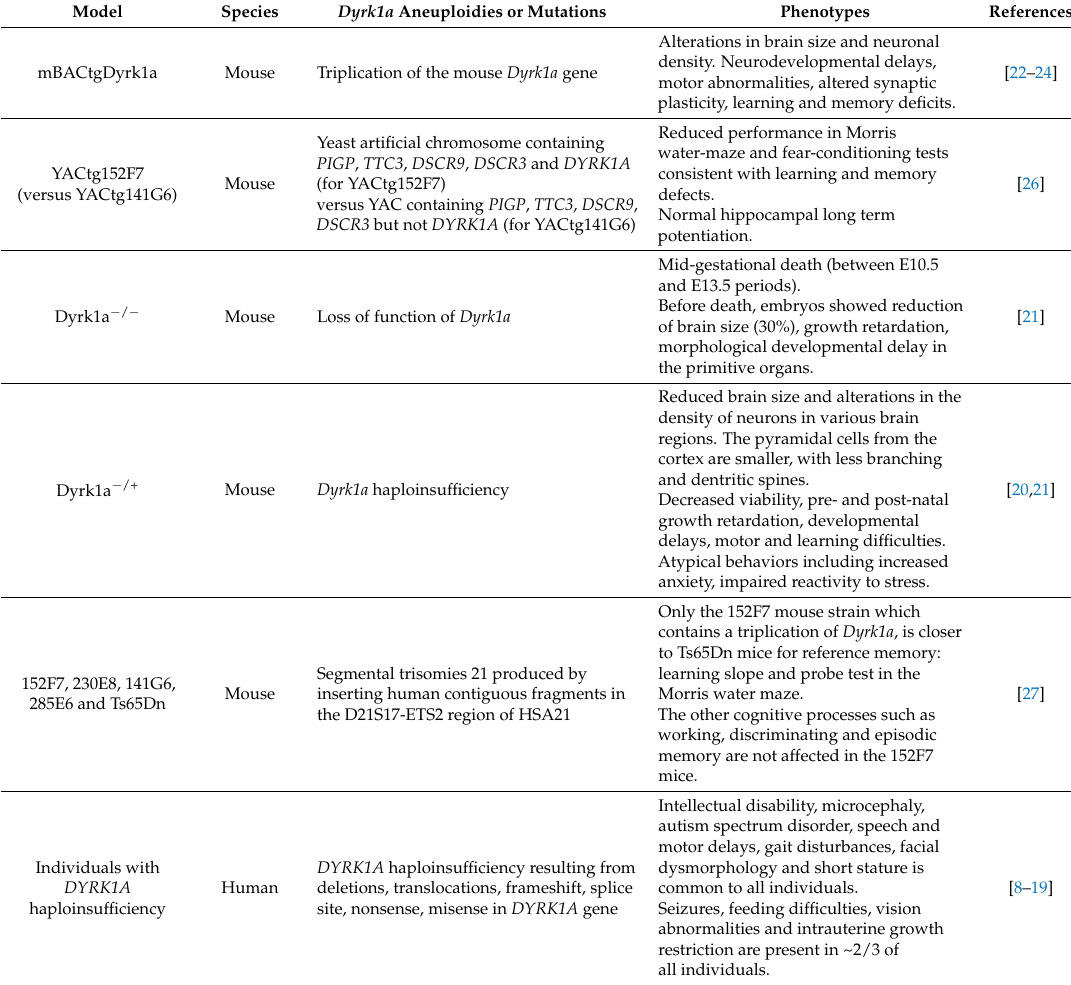
Table 1. DYRK1A aneuploidies or mutations in human and